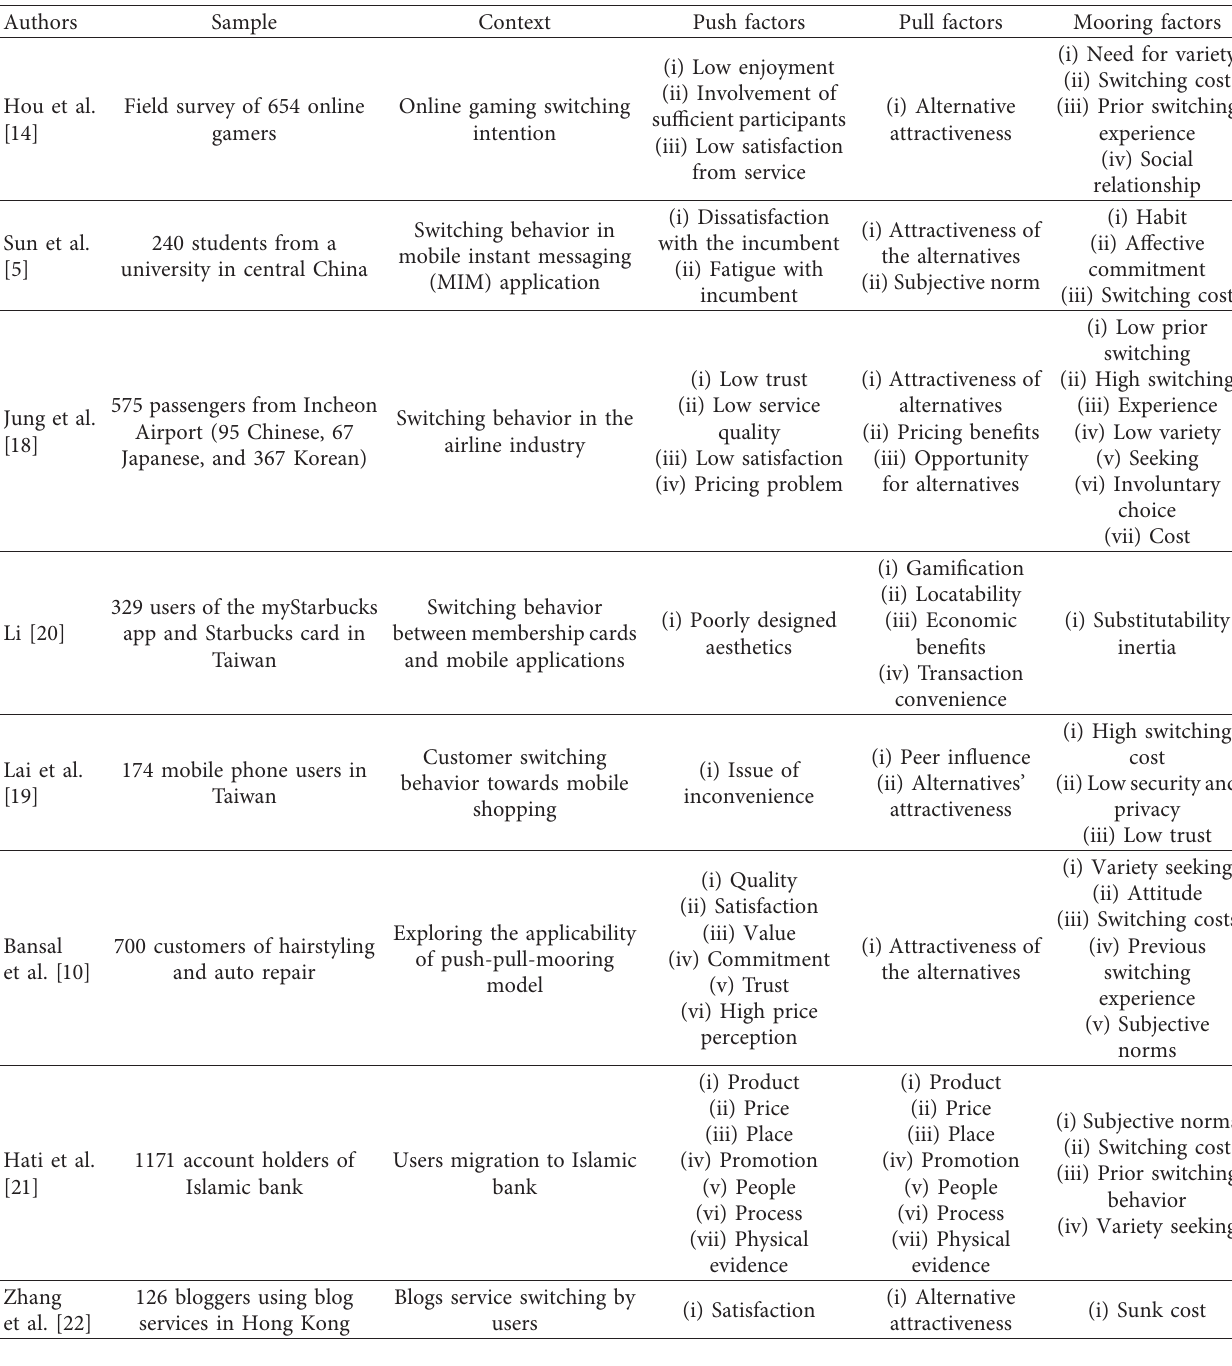
Table 1: Prior research in the PPM model: push, pull, and mooring